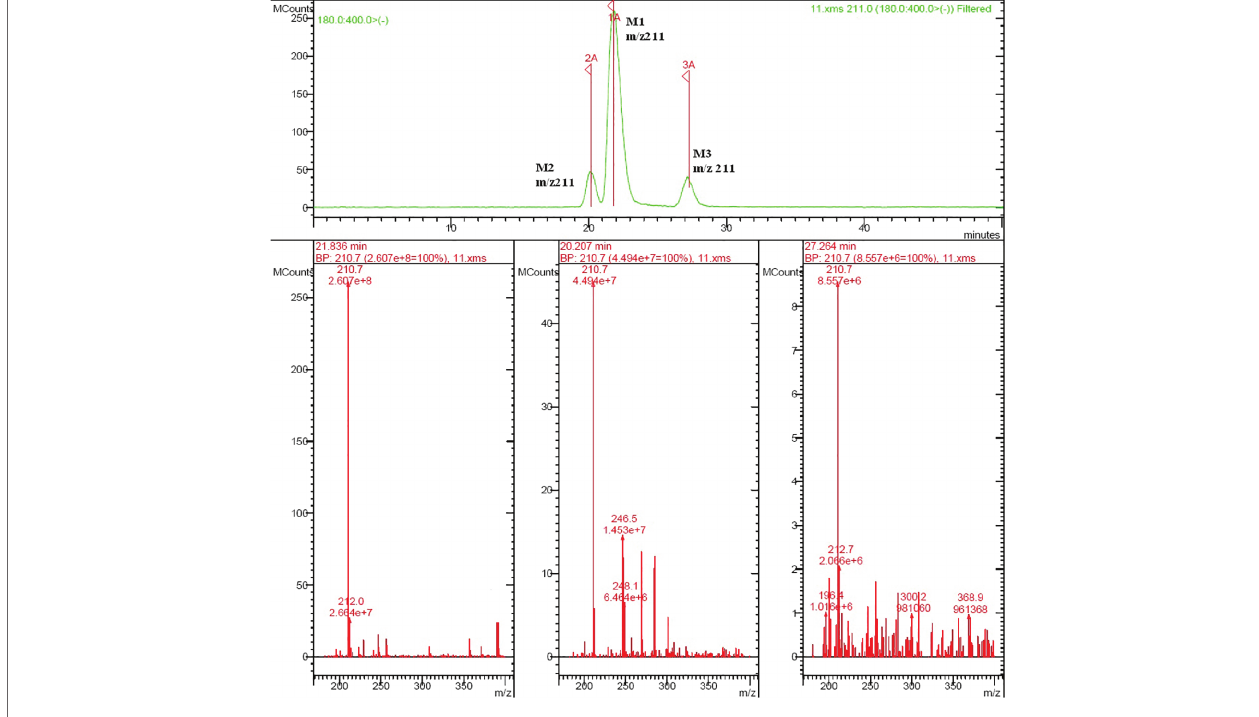
FIGURE 5 | EIC of rat urine sample at m/z 211.